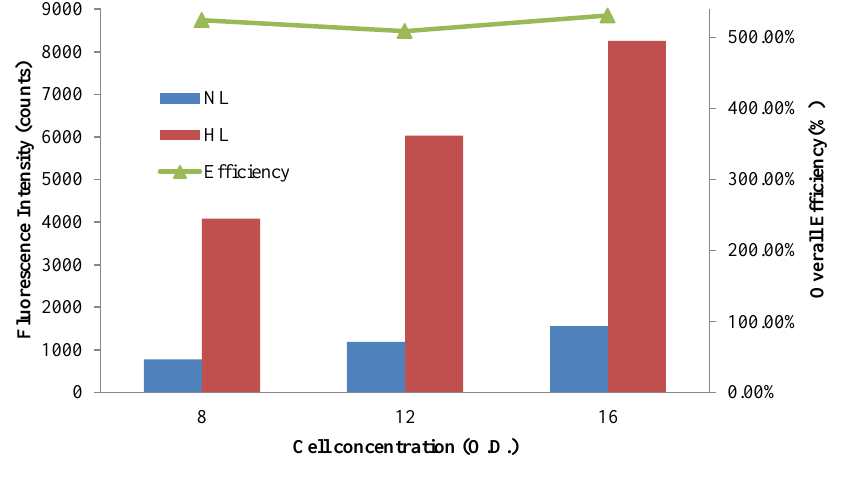
Figure 11. The fluorescence intensity obtained with the hybrid lens (HL) and without lens (NL) in the detection of Nile Red-labeled Chlorella vulgaris cells. The overall fluorescence detection efficiency is also plotted for different concentrations (O.D.) of